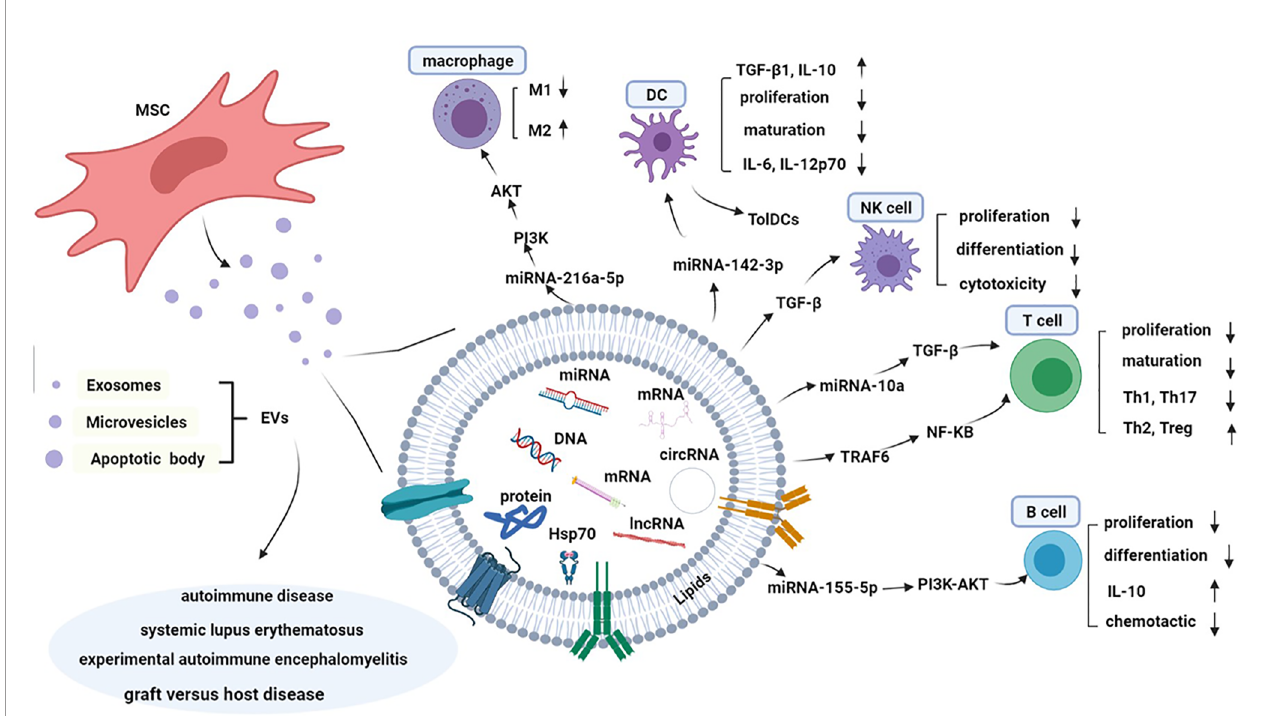
FIGURE 1 | Composition and mechanism of immunological tolerance of MSC-EVs in systemic lupus erythematosus. MSC-EVs are spheroidal shaped and two-layer lipid particles containing various types of protein, lipids, DNAs, non-coding RNAs, miRNAs, and mRNA, which cause genetic information exchange by various of signal pathway and reprogramming of the recipient cell. MSC-EVs can suppress the differentiation and proliferation of B cell by PI3K-AKT pathway, and reduce production of IL-10. Similarly, T cells play the suspensive role on the proliferation and maturation, while reduce production of Th17 and Th1, and improve function of Treg and Th2 through the TGF- b /NF- k B pathway. EVs can suppress the proliferation and maturation of DCs and induce tolerable DCs with low expression of costimulatory makers. Macrophages can transform to anti-in fl ammatory M2 phenotype after treating by MSC-EVs through the PI3K/AKT pathway. EVs can suppress the proliferation, differentiation and cytotoxicity of NK cells in a TGF- b dependent manner. MSC-EVs play an important role in the pathogenesis of autoimmune diseases, including SLE, graft versus host disease, experimental autoimmune encephalomyelitis,